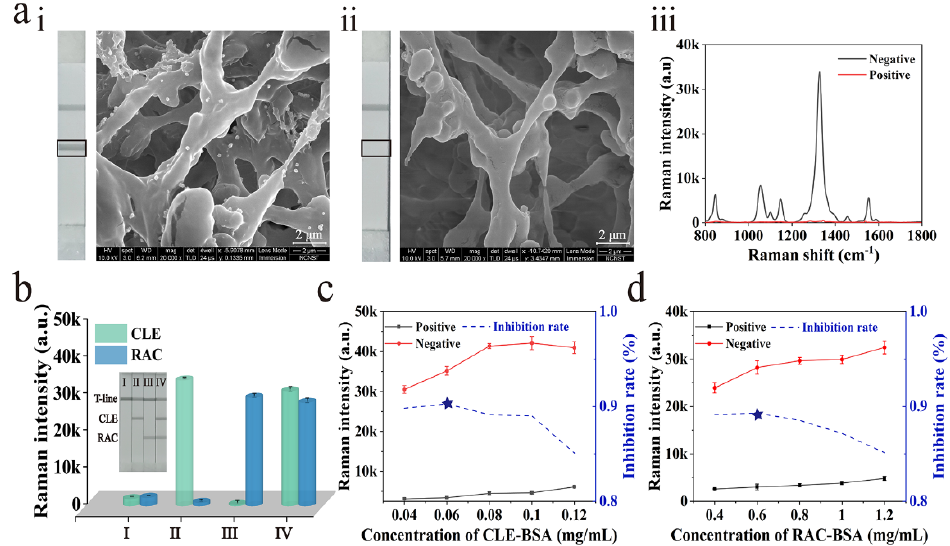
Figure 2. ( a ) Diagrams of the test strip and corresponding SEM images in ( i ) the negative case, ( ii ) the positive case, and ( iii ) the corresponding SERS signal intensity on the T-lines. ( b ) Graphs of the test strips with different concentrations of CLE and RAC (I: 10, 10 ng mL − 1 ; II: 0, 10 ng mL − 1 ; III: 10, 0 ng mL − 1 ; IV: 0, 0 ng mL − 1 ) and the SERS signal intensity of the corresponding T-lines. ( c , d ) Effect of different concentrations of CLE-BSA and RAC-BSA on the competition inhibition rate, the blue five- pointed star represents the position with the highest rate of competition suppression. The error bar is the standard deviation of five independent tests based on Mag@Au-ICA.